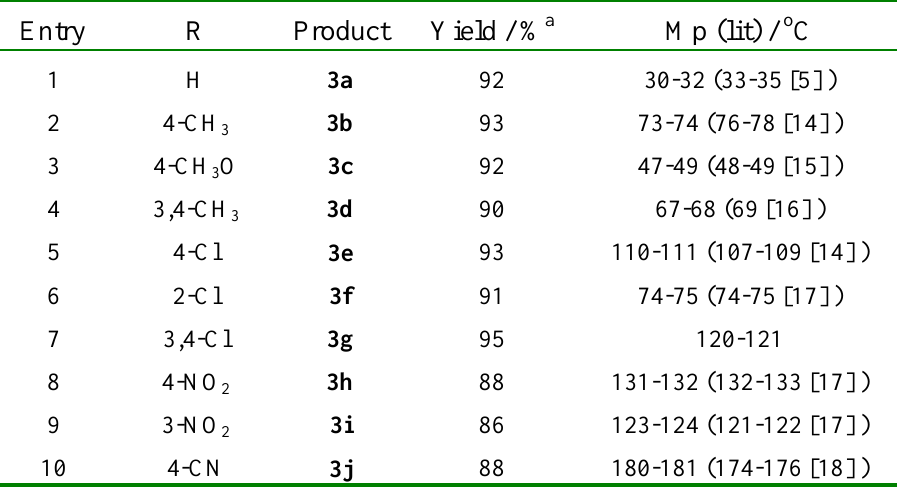
Table 1 . One-pot synthesis of aldoximes from aldehydes, 2 and